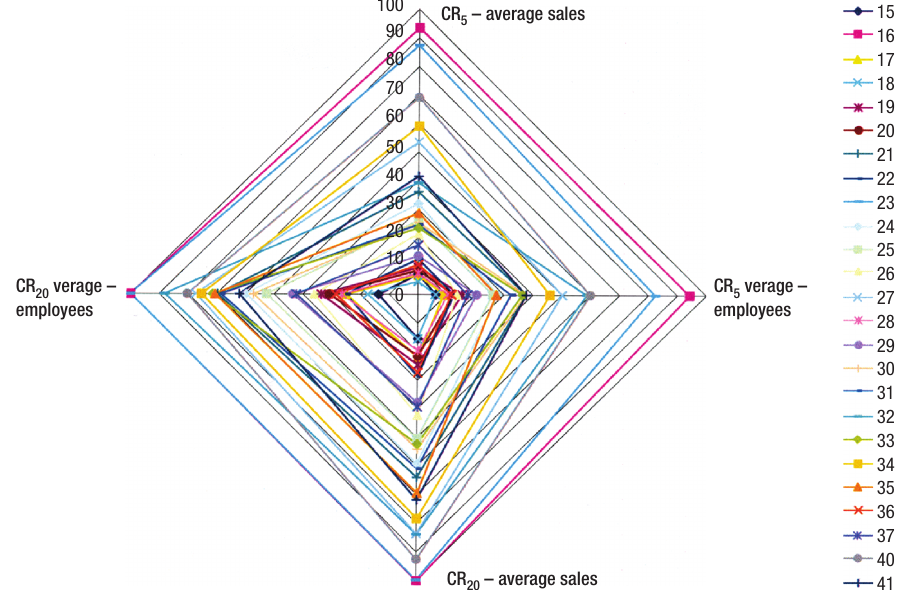
Fig. 6. The map of Romanian industry